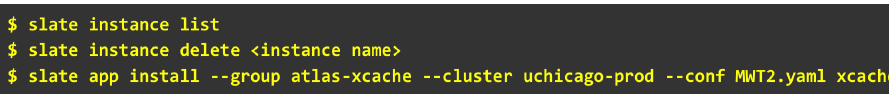
Figure 6: SLATE command line deployment example illustrating deployment of an XCache service instance on a production Kubernetes cluster at the University of Chicago, within the MWT2 network and tested with the site’s job queues.